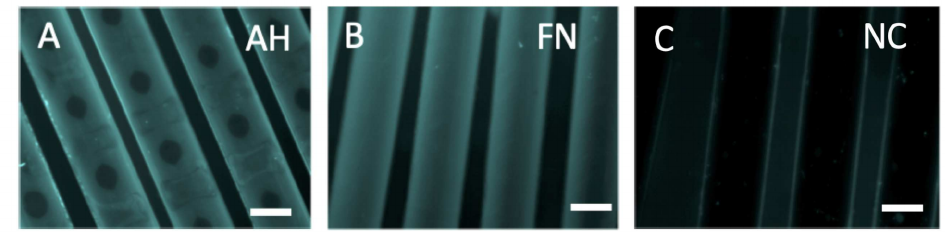
Figure 1. Analysis of coating distribution on HFM. TAMRA staining ( cyan ) was used to visualize the